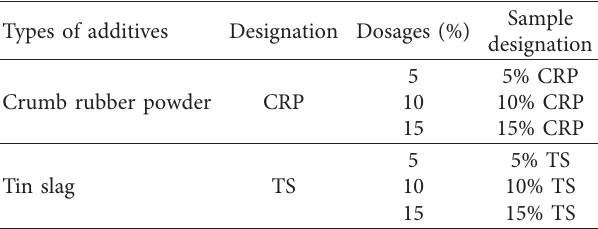
Table 2: Percentages of additives